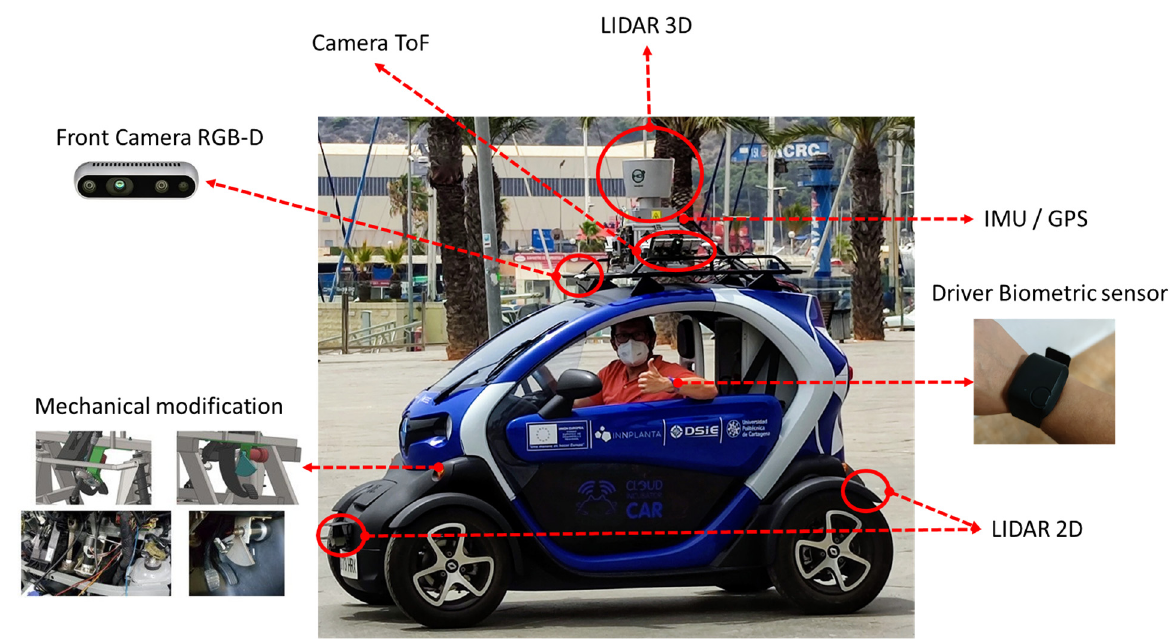
Figure 3. Autonomous vehicle UPCT-CICar and its different sensors and devices. Table 3. Sensor data in CICar. Table 4. Biometric variables